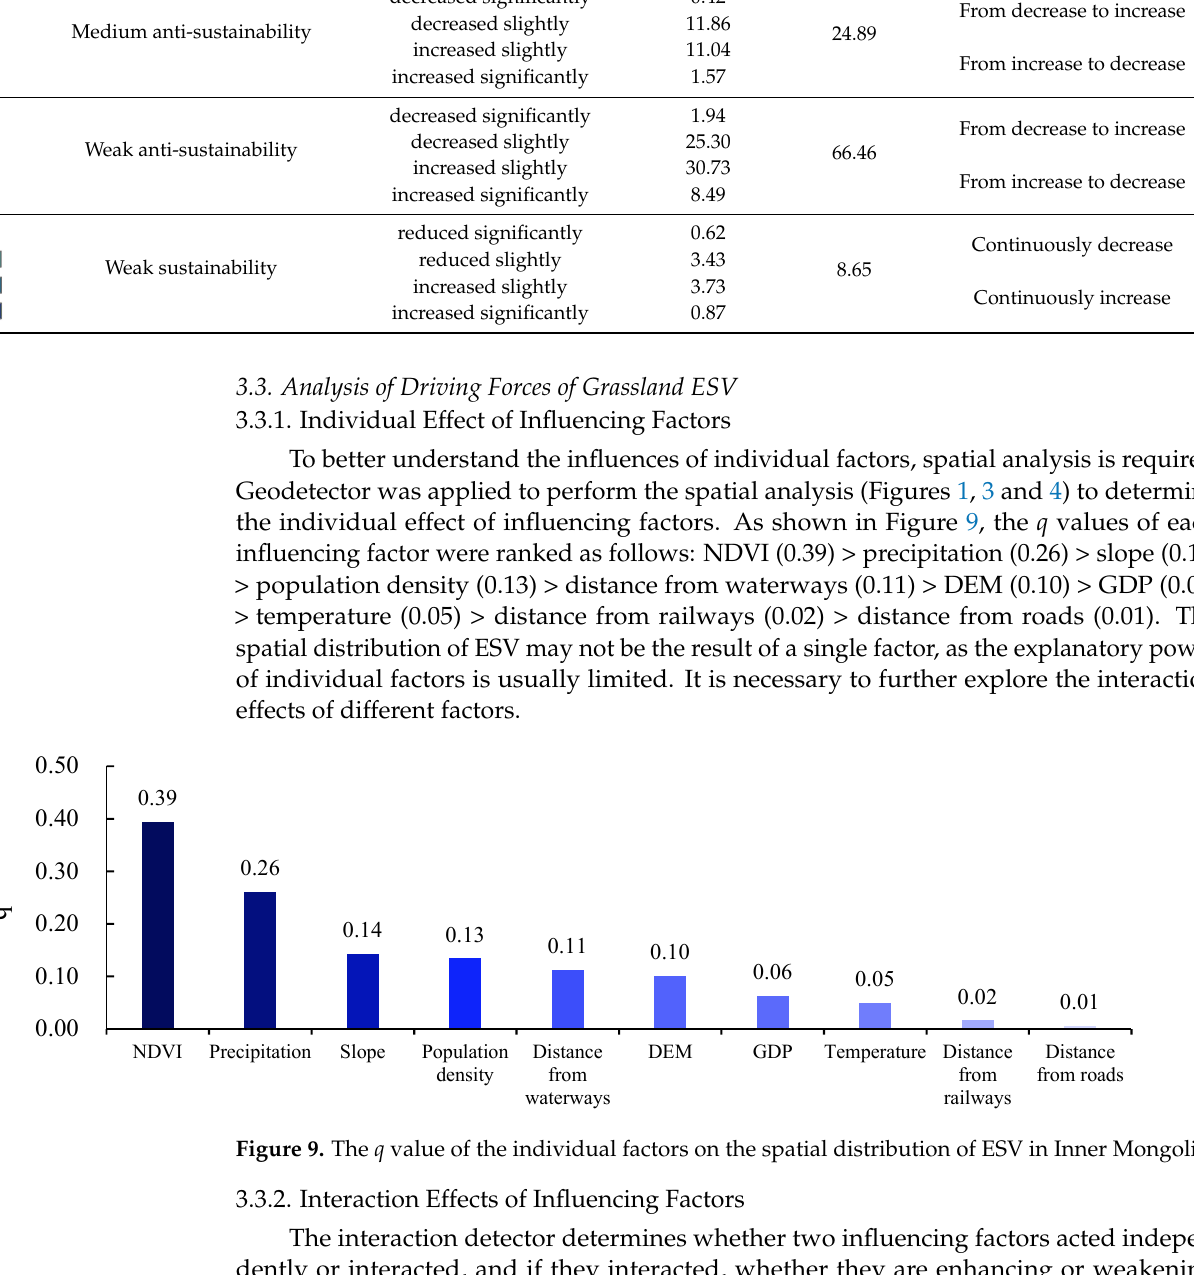
Figure 8. Future trends of grassland ESV in Inner Mongolia.